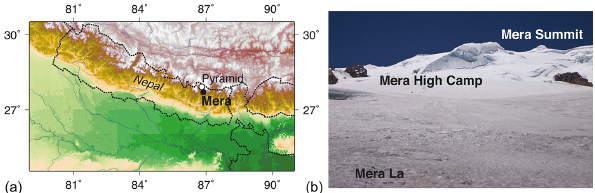
Figure 2. (a) Location of Mera Peak and Nepal Climate Observatory-Pyramid, and (b) Picture of Mera glacier taken during April 2009 showing the location of Mera La (5400ma.s.l.), Mera High Camp (5800ma.s.l.), and Mera Summit (6400ma.s.l.). Photo taken by Jesse